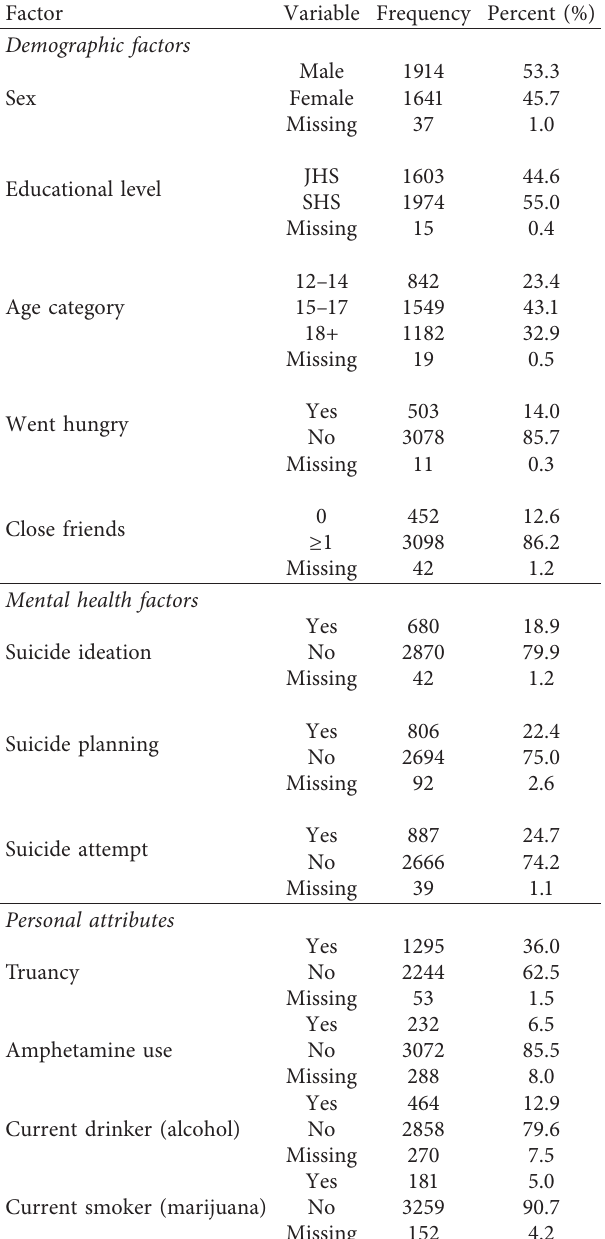
Table 2: Background characteristics of the school-going adoles- cents in Ghana ( n � 3592).